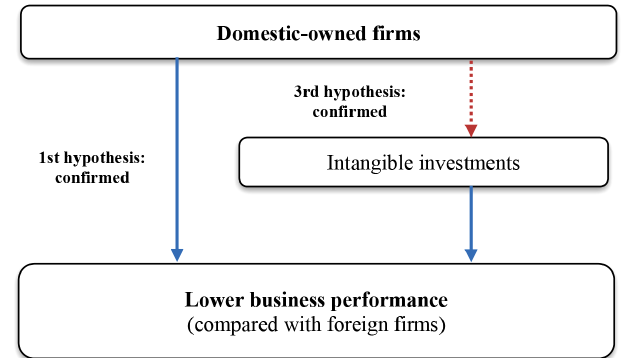
Figure 3. Confirmation of research hypotheses in domestic firms (source: